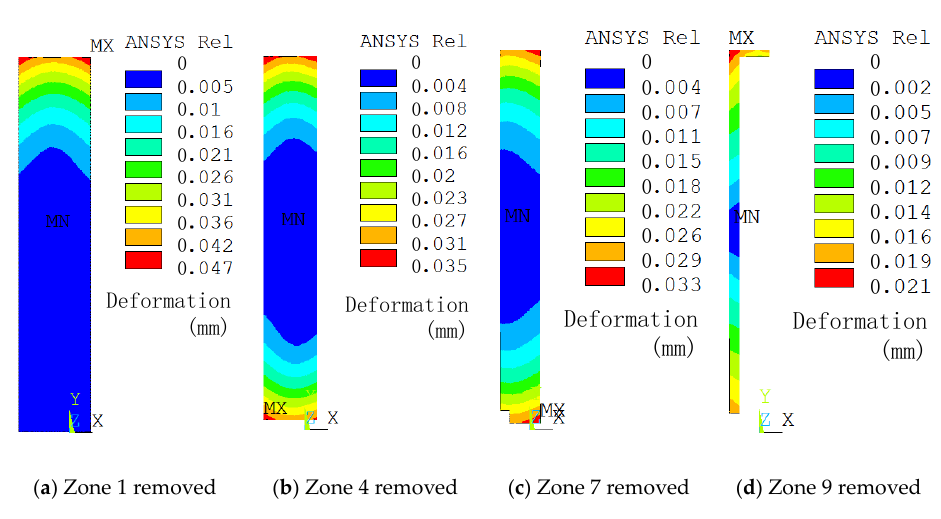
Figure 16. Maximum distortion during material removal in the original process.